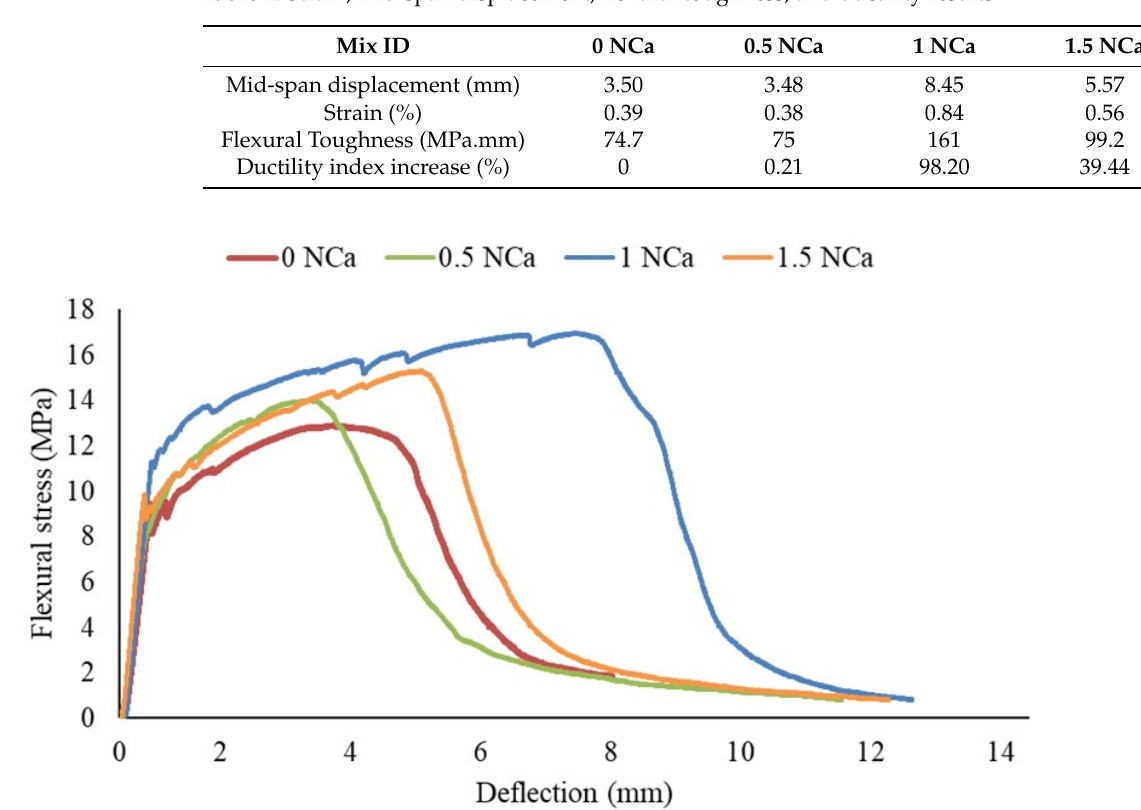
Figure 11. Flexural stress–deflection curves of the specimens. Ductility and flexural toughness can be evaluated using flexural load-deflection curves, as indicated in the literature [52,53]. The area under the whole load-deflection curve is